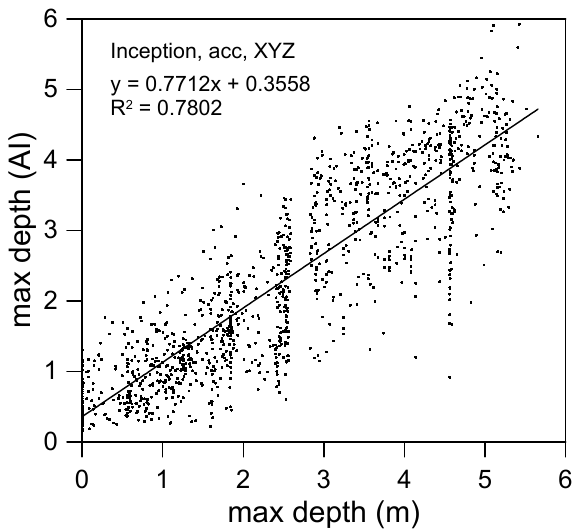
Figure 13. Maximum flooding depth predicted by AI versus the actual data.